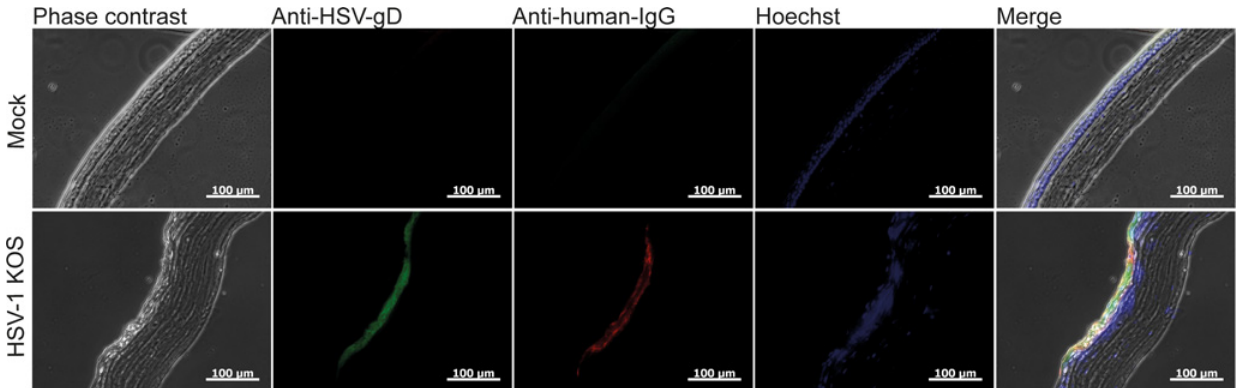
Figure 12. Colocalization of mAb hu2c and HSV antigens in HSV-1 KOS infected corneas. Mice were intravenously injected with 300 µ g of mAb hu2c (lower line) or PBS (upper line) at 48h after corneal infection with HSV-1 KOS. Six hours after injection, eyes were removed and sectioned. HSV-1 infection was stained with polyclonal goat anti-HSV-1 FITC conjugated antibodies and bound humanized antibody was detected with a Cy3-conjugated goat anti- human IgG secondary antibody. Nuclei were stained with Hoechst. Immunofluorescence images were acquired with a Zeiss Observer Z1 fluorescence microscope at a 200-fold magnification. Scale bars: 100 μ